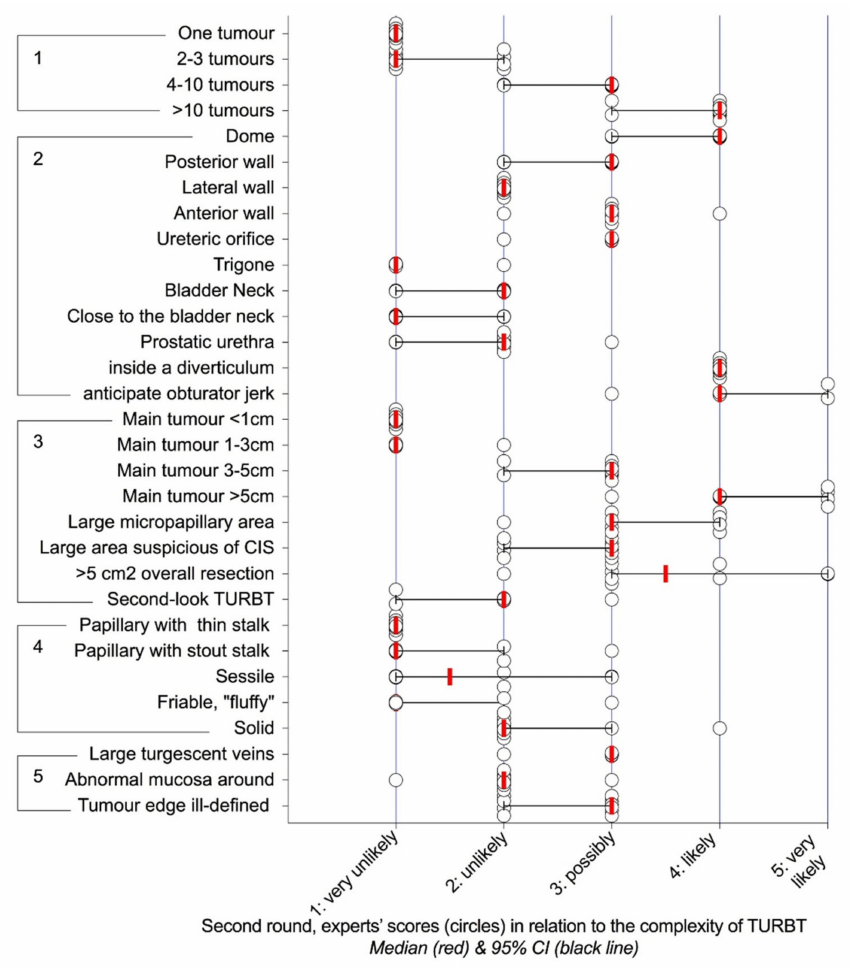
Figure 2. Distribution of the scores regarding the likelihood of incomplete resection and / or prolonged surgery ( > 1 h) and / or significant (Clavien-Dindo ≥ 3) perioperative complications according to tumour’s characteristics: ((1) number, (2) location, (3) size, (4) structure, (5) surroundings. CIS: carcinoma in